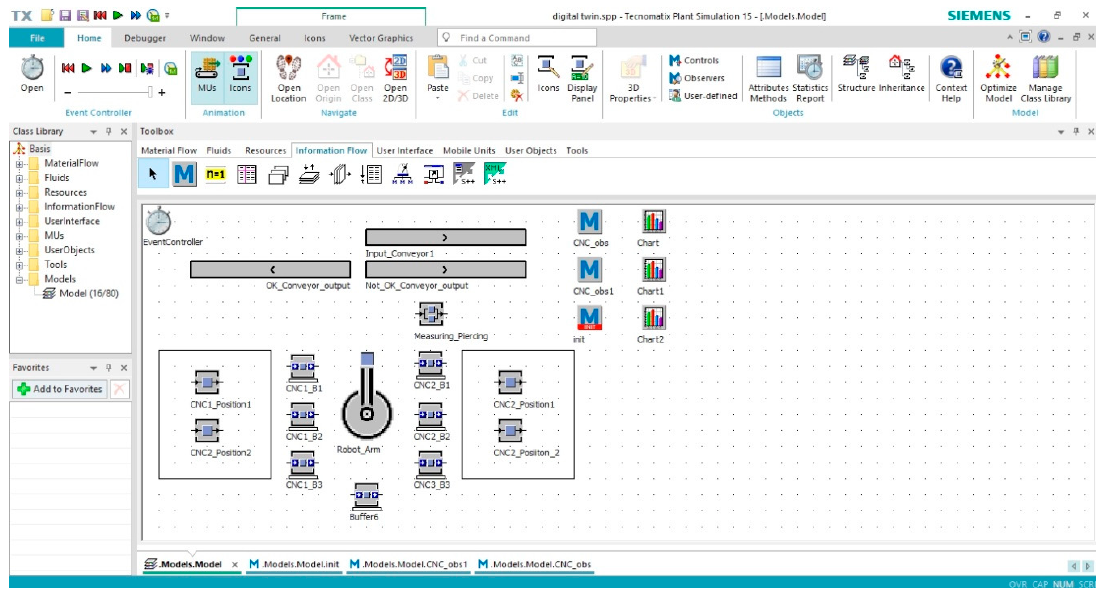
Figure 3. Development of simulation model in the Tecnomatix Plant Simulation environment.